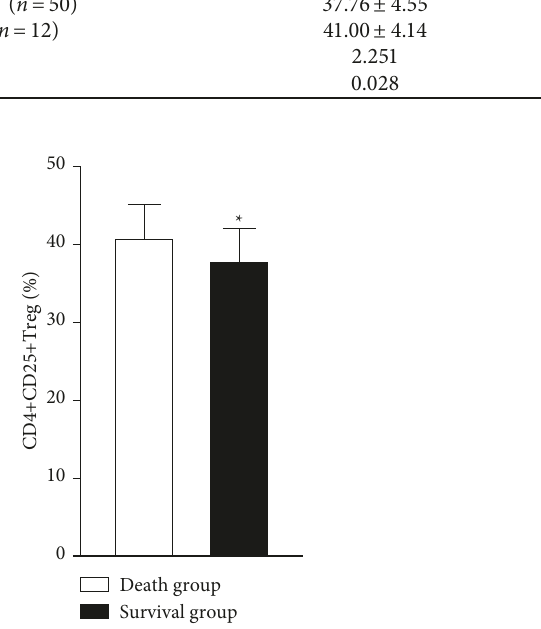
Figure 1: Distribution of CD4 +CD25+Treg in survival group and death group.